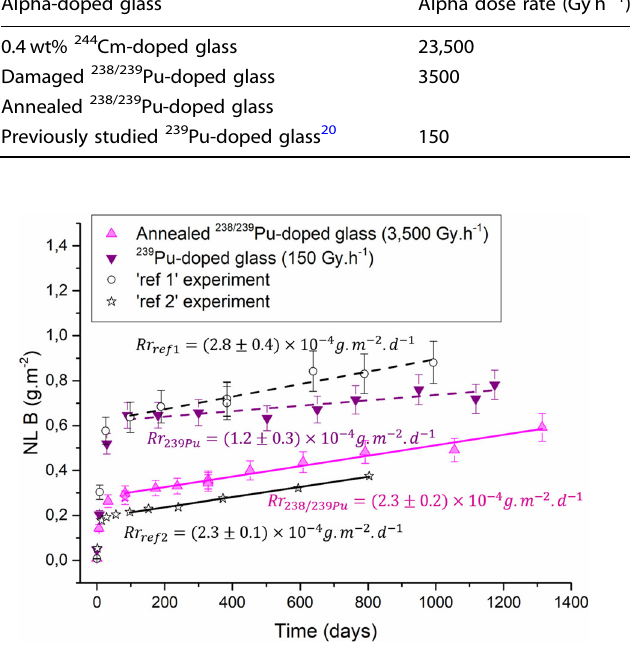
Fig. 3 Boron normalized mass loss (NL B) versus time for annealed (pink triangles) and damaged (green diamonds) 238/ 239 Pu-doped glass leaching tests. Solid lines represent residual alteration rate. Error bars are of ±10% and their calculation is detailed in the “ Solution analyses ” section.